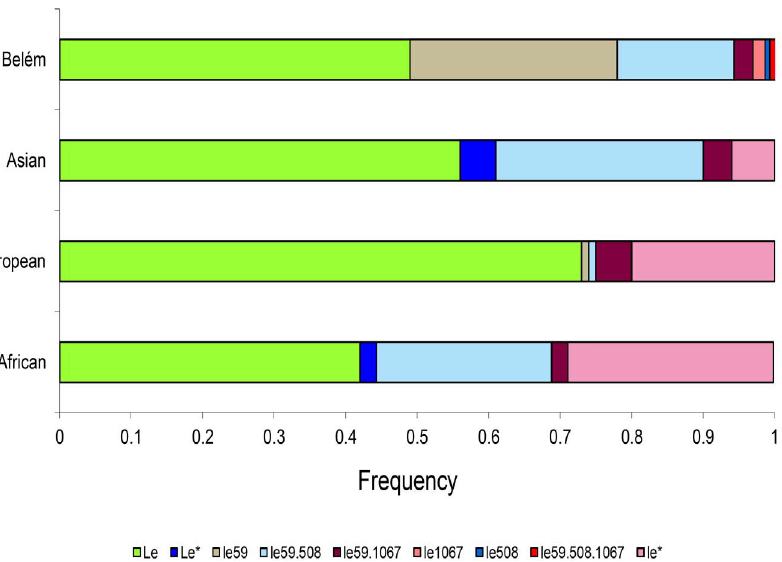
Figure 2. Comparison of the allele frequencies for the FUT3 gene recorded in different populations. The frequencies for the African (Accra, Ghana), European (Caucasians from Coriell and Camden, NJ, USA), and Asian (Ulaanbaatar, Mongolia) were obtained from Soejima et al. [11]. Alleles not detected in the present study are designated by an asterisk (*).